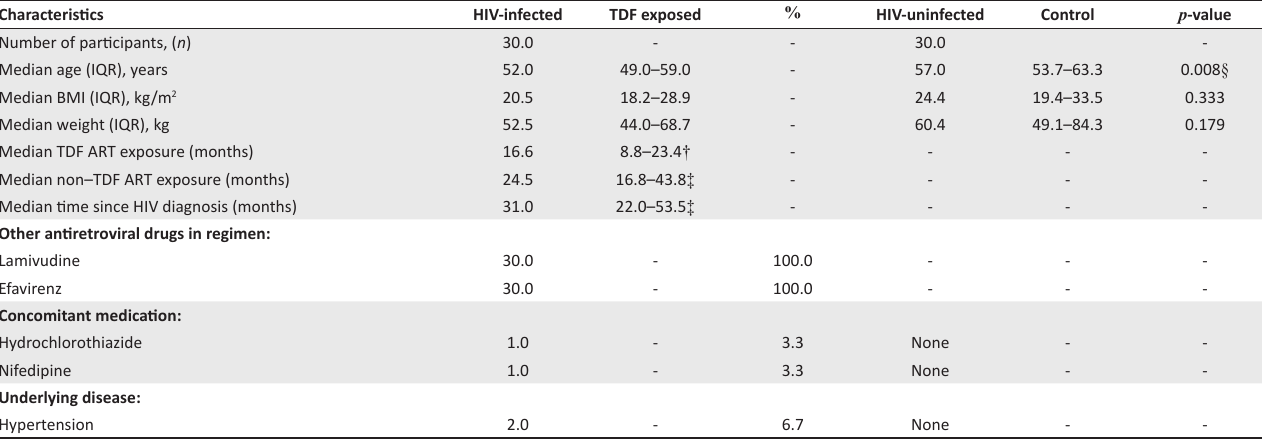
TABLE 1: Characteristics of HIV-infected and uninfected women (control group). Characteristics